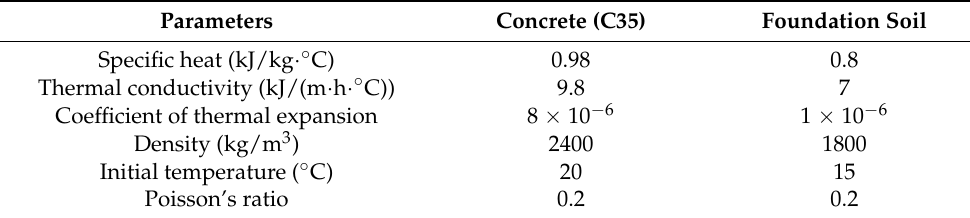
Table 1. Thermal properties of concrete and foundation soil of the metro station.